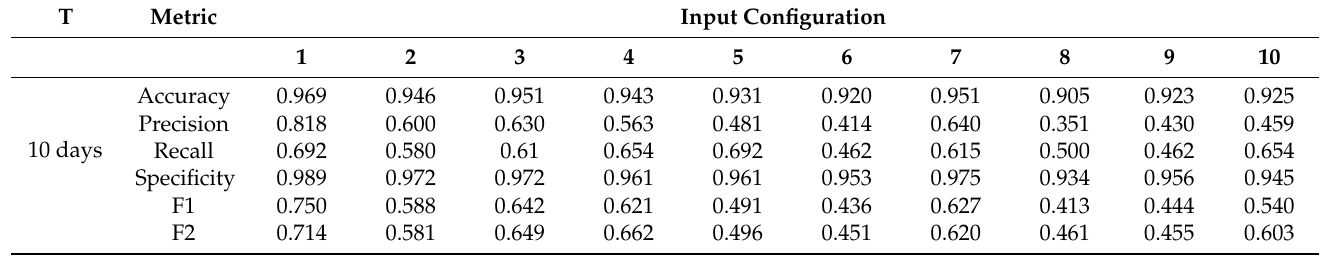
Table 6. SVM model performance metrics with the MWMOTE-balanced dataset.